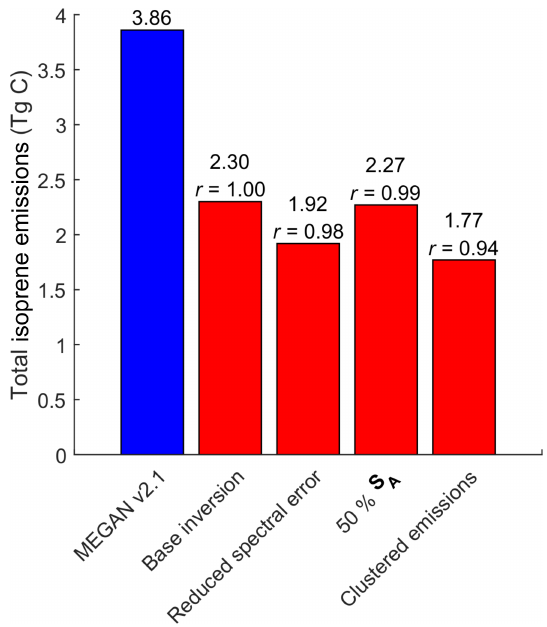
Figure 3. Total isoprene emissions for the southeast US domain of Fig. 1 over the period 1 August – 25 September 2013. The MEGAN v2.1 inventory value is compared to results from the base inver- sion applied to the OMI formaldehyde data (optimized emissions in Fig. 2) and to sensitivity inversions using different error speci- fications (see text for details). Numbers on top of each bar are the total isoprene emissions, and correlation coefficients ( r ) describe the spatial consistency between the base inversion ( r = 1) and the sensitivity